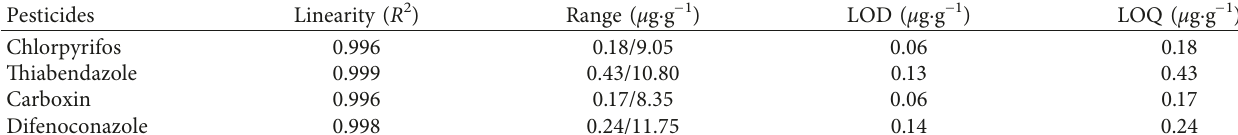
Table 2: Analytical parameters of the SLE-LTP method of pesticide residues from the caj´a-manga pulp.